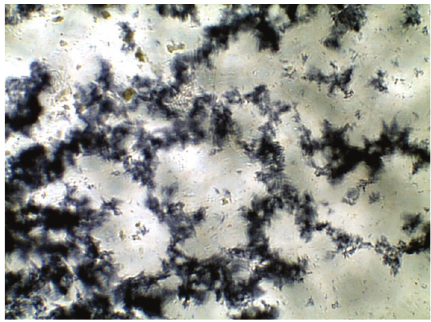
Figure 4: Agglutination reaction of standard